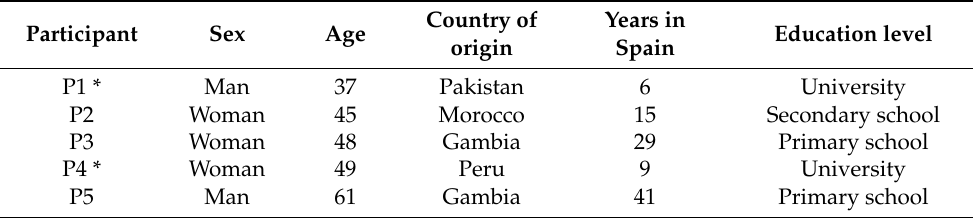
Table 2. Characteristics of interview